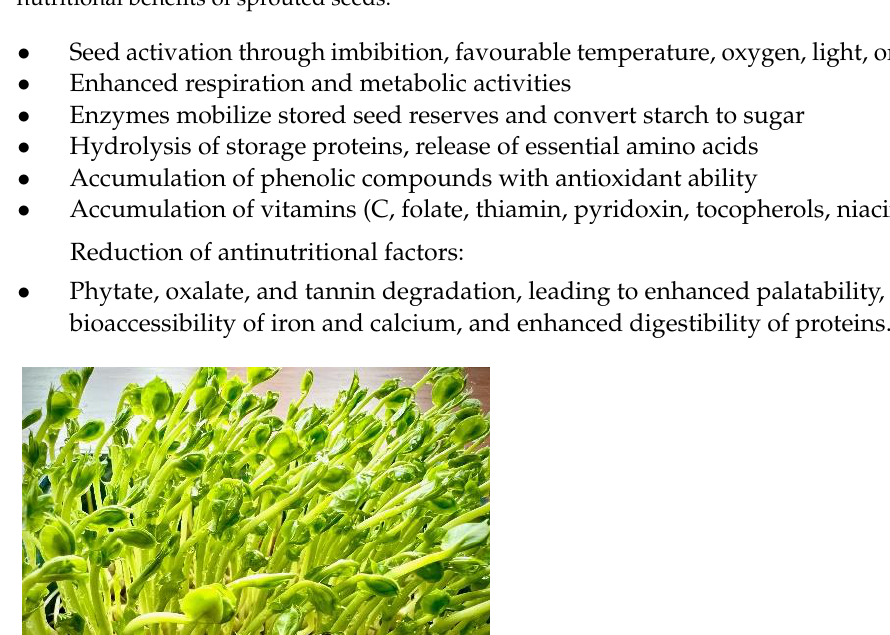
Figure 2. Home-grown 3-day old pea ( Pisum sativum ) sprouts. Seed germination process and nutritional benefits of sprouted seeds.